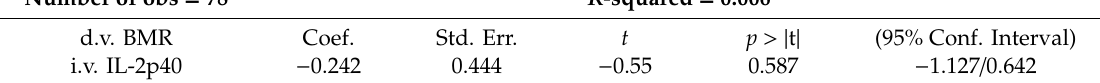
Legend to Table 3: FF, fat mass; FFM, free fat mass; RMR, resting metabolic rate; RMR / FFM, resting metabolic rate / free fat mass ratio; SLD, spleen longitudinal diameter at ultrasonography. The low R-squared, in presence of significance, shows that even noisy, high-variability data can have a significant trend, even though data points fall further from the regression line in graph; d.v., dependent variable; i.v., independent variable. In bold are